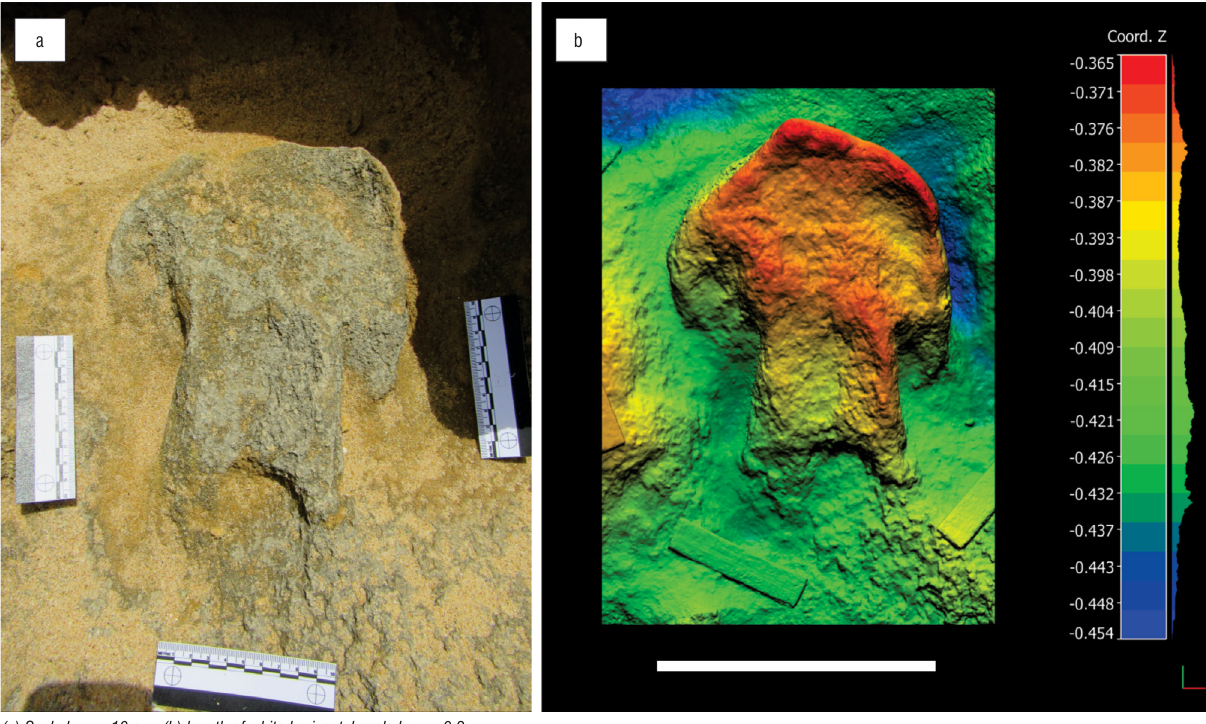
Figure 10: (a) Probable Equus capensis track on Megafauna Rock. (b) Photogrammetry colour mesh: probable Equus capensis track on Megafauna Rock. 3D model was generated with Agisoft Photoscan Professional (v. 1.0.4) using 32 images from a Canon PowerShot ELFPH 340 HS (focal length 4.5 mm; resolution 4608 x 3456; pixel size of 1.33853 x 1.33853 µm). Photos were taken an average of 0.4 m from the surface. The surface model error is 0.138061 pix. The final images presented here were rendered using CloudCompare (v.2.6.3.beta). Vertical scale bar is in